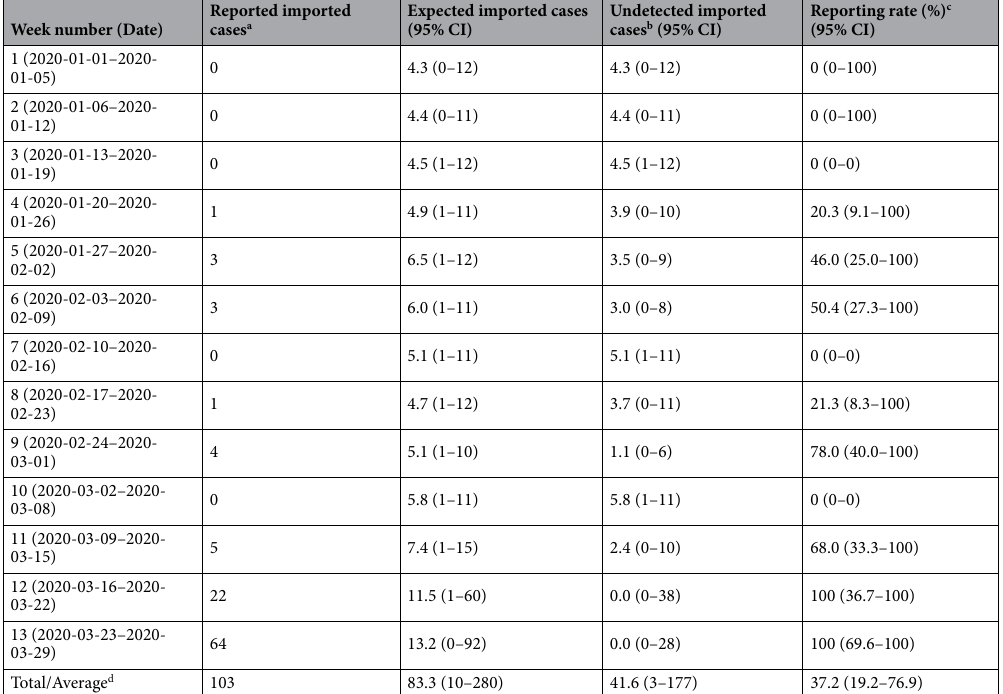
Table 1. Weekly reported, expected, undetected imported cases, and reporting rate. a Indicates cases from the selected 23 countries. b Expected imported cases – reported imported cases. c Expected imported cases/reported imported cases * 100. d The total is provided for the reported, expected, undetected imported cases, and the average is provided for the reporting rate.